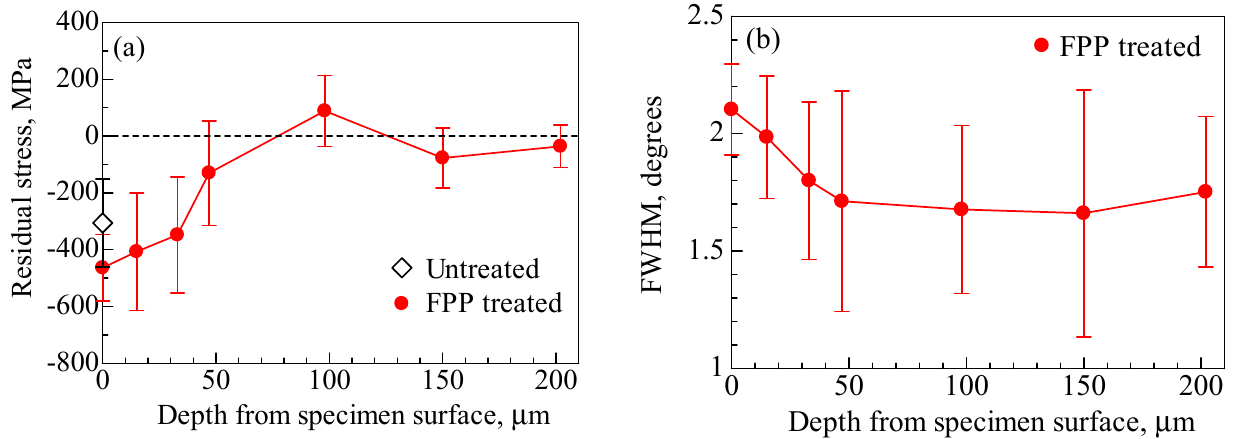
Figure 8. ( a ) Residual stress and ( b ) FWHM values as a function of depth into the surface of FPP-treated specimen.